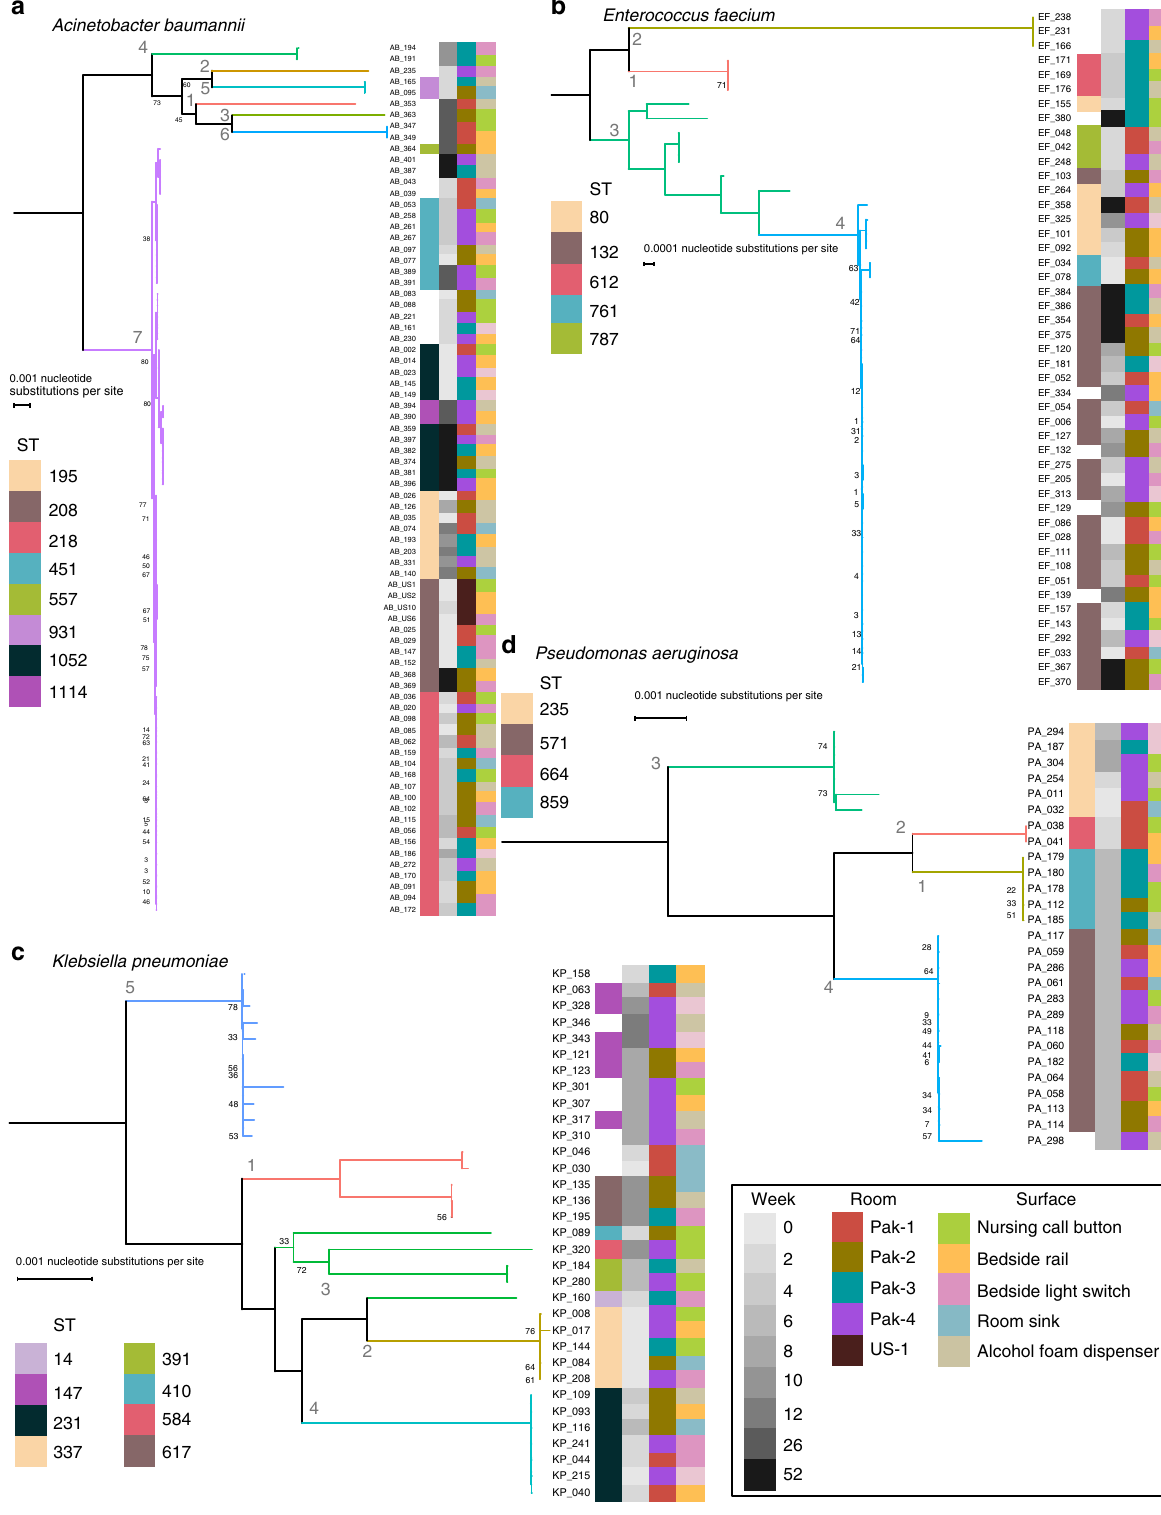
Fig. 3 Phylogenetic trees of high abundance species from core genome alignments. Maximum likelihood phylogenetic trees from core genome alignments of A. baumannii ( a ), E. faecium ( b ), K. pneumoniae ( c ), and P. aeruginosa ( d ). Tree branches are colored by hierBAPS lineage and these lineages are colored in subsequent fi gures. Sequence type, week, room, and surface are annotated as colored bars next to the isolate number. Week is given as grayscale with darker values corresponding to later weeks. The US room that yielded isolates is annotated dark brown. The Pakistan rooms are red, olive, turquoise, and purple for rooms 1 – 4, respectively. Surfaces are lime green for nursing call button, light orange for bedside rail, pink for bedside light switch, blue for